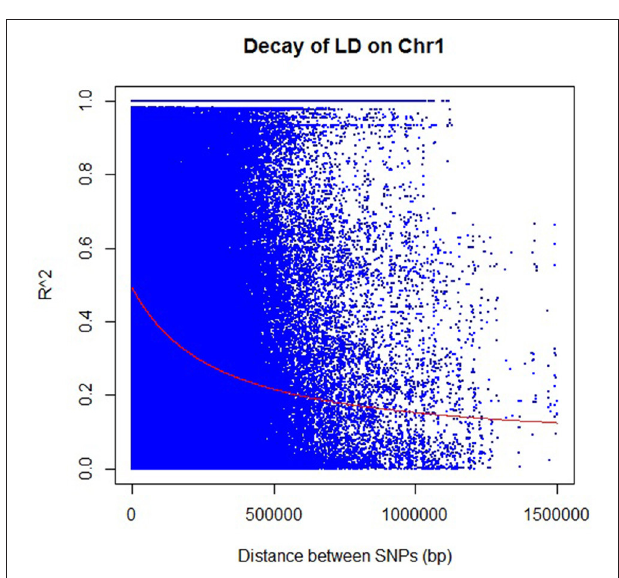
FIGURE 4 | Rice chromosome 1 linkage disequilibrium (LD) decay as the representative figure for other chromosomes (plots for other 11 chromosomes are in Supplementary Figure 4 ). Each dot represents LD ( r 2 ) between a pair of SNPs, as a function of the distance (in bp). The red line shows the regression used to describe the relationship between the pairwise distance and r 2